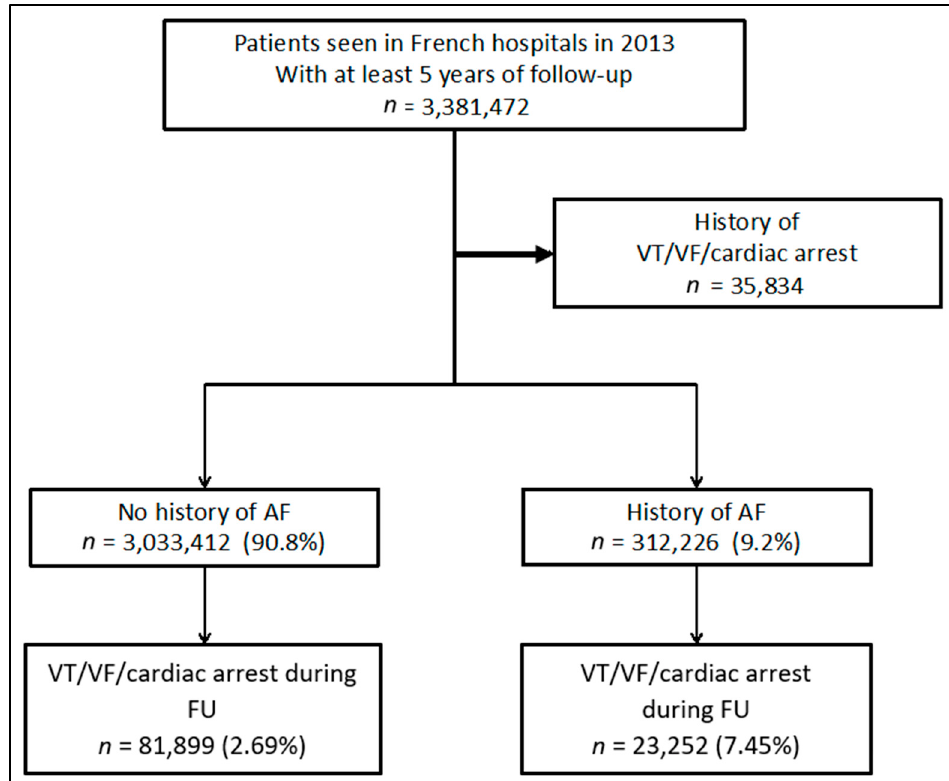
Figure 1. Study selection process. Abbreviations: AF—atrial fibrillation; FU—follow-up, VF—ven- tricular fibrillation; VT—ventricular tachycardia.